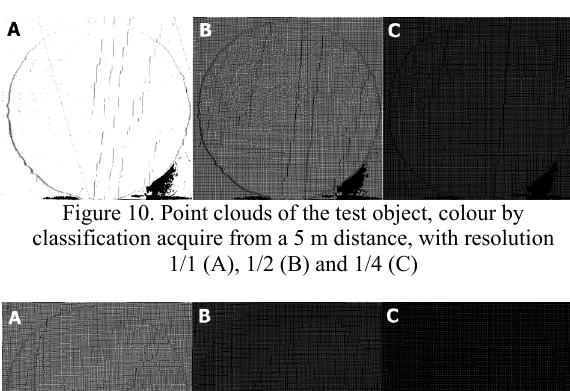
1/1 (A), 1/2 (B) and 1 / 4 (C).